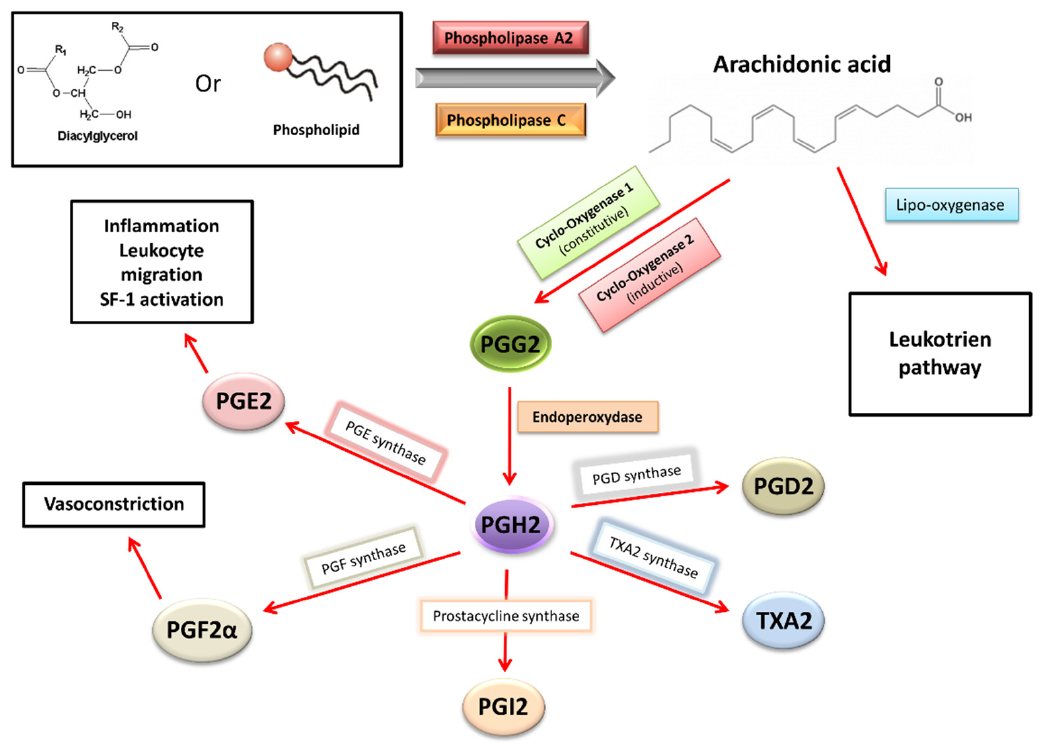
Figure 2. Prostaglandins synthesis and effects in endometriosis [4,5].